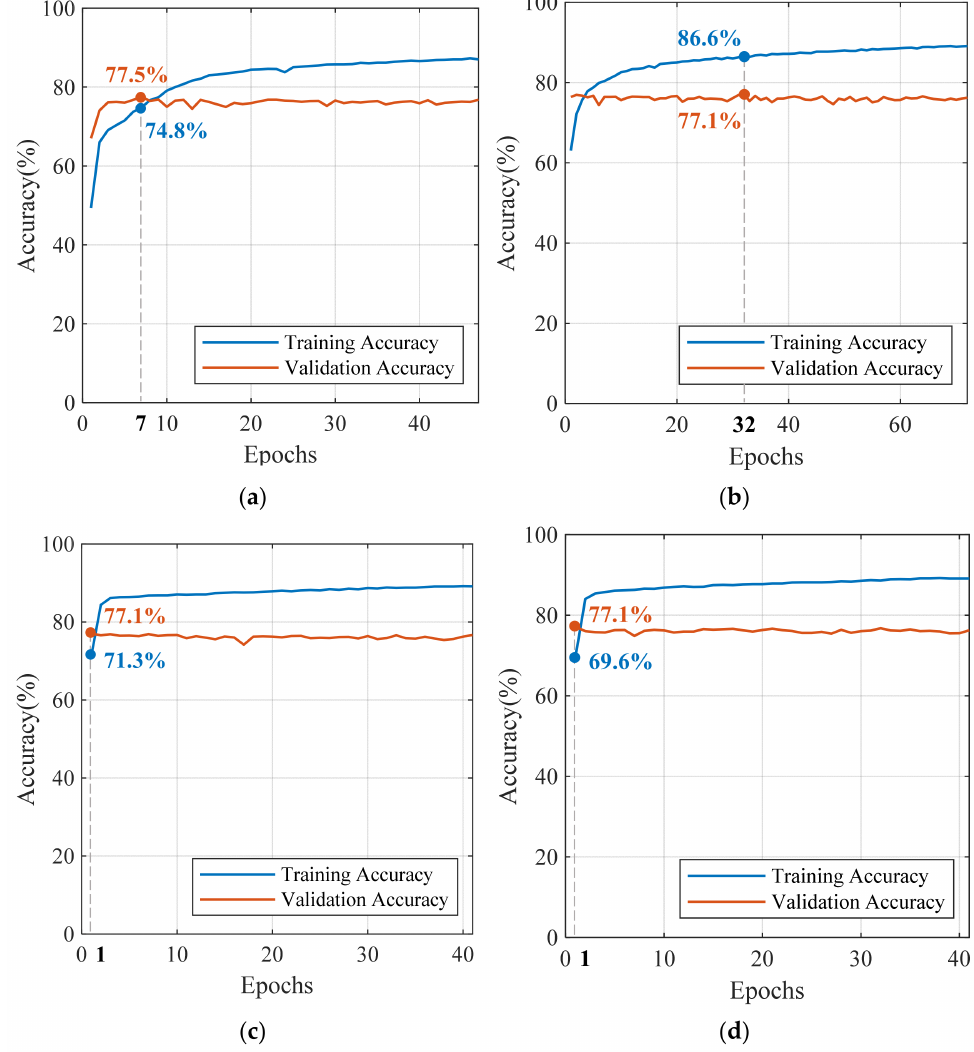
Figure 7. Training and validation accuracies of the four batches: ( a ) Batch 1; ( b ) Batch 2; ( c ) Batch 3; ( d ) Batch